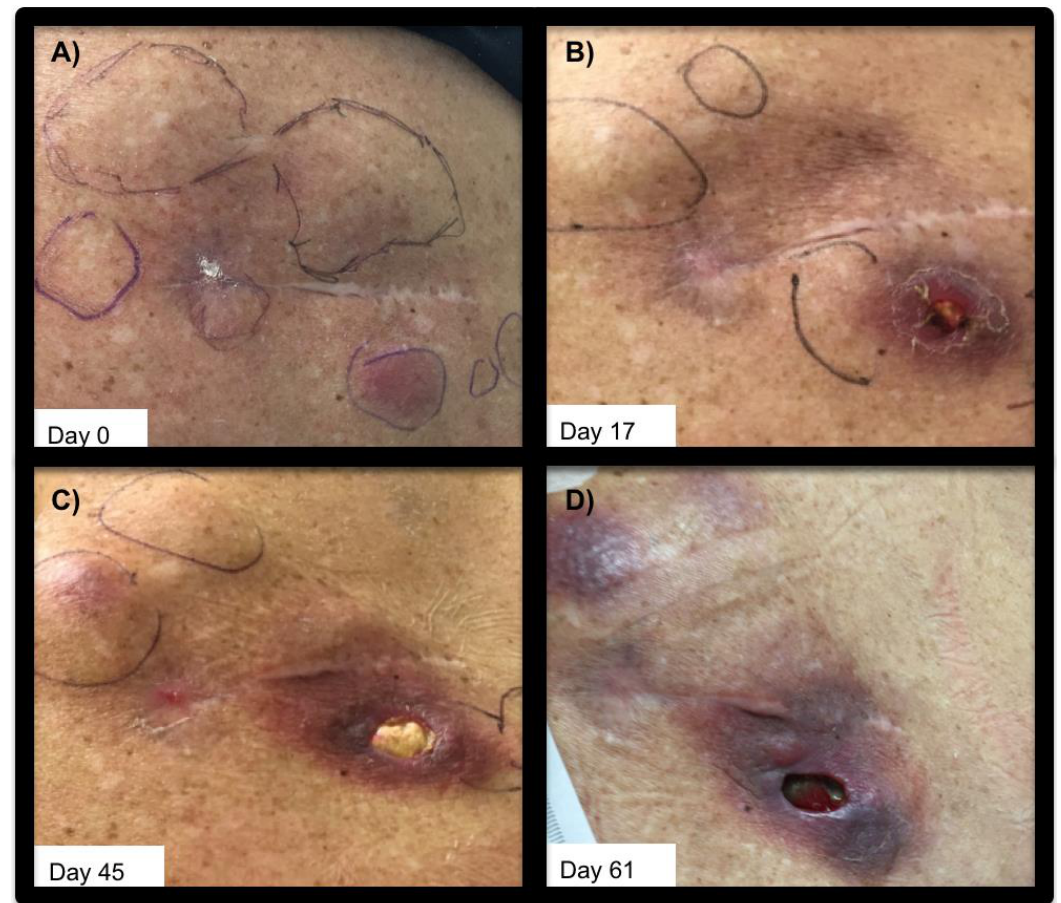
Figure 1. Subcutaneous DLBCL lesions pre- and post- CAR T cell infusion. Subcutaneous DLBCL lesions superficial to right scapula, shown ( A ): prior to CAR T infusion (day 0) ( B ): 17 days post-infusion of CAR T cells, ( C ): 45 days post-CAR T, and ( D ): day 61 post-CAR T infusion. Left is medial, and right is lateral.